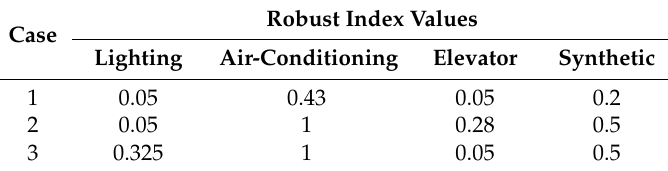
Table 6. Robust index values of different systems.